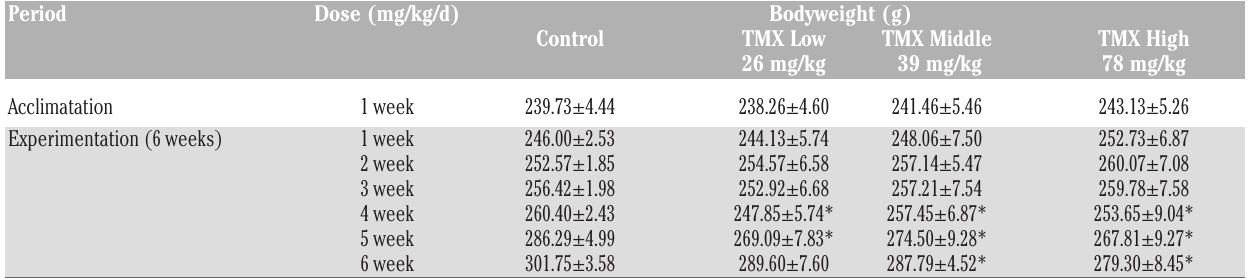
Table 1. Body weight gain in rats after oral administration of thiamethoxam (26, 39 and 78 mg/Kg/b.w.of TMX) for 6 weeks.